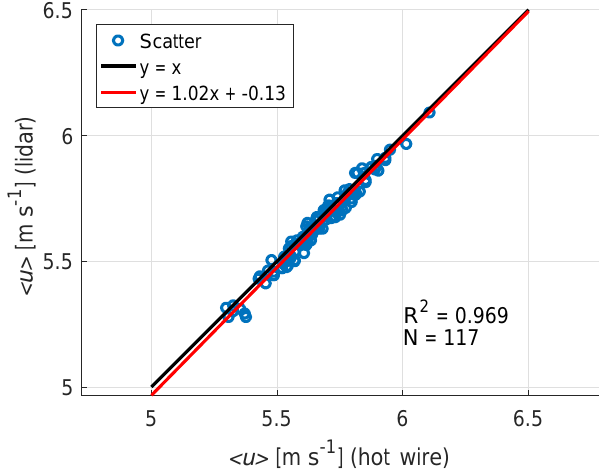
Figure 16. Correlation of the 1Hz averaged u component.